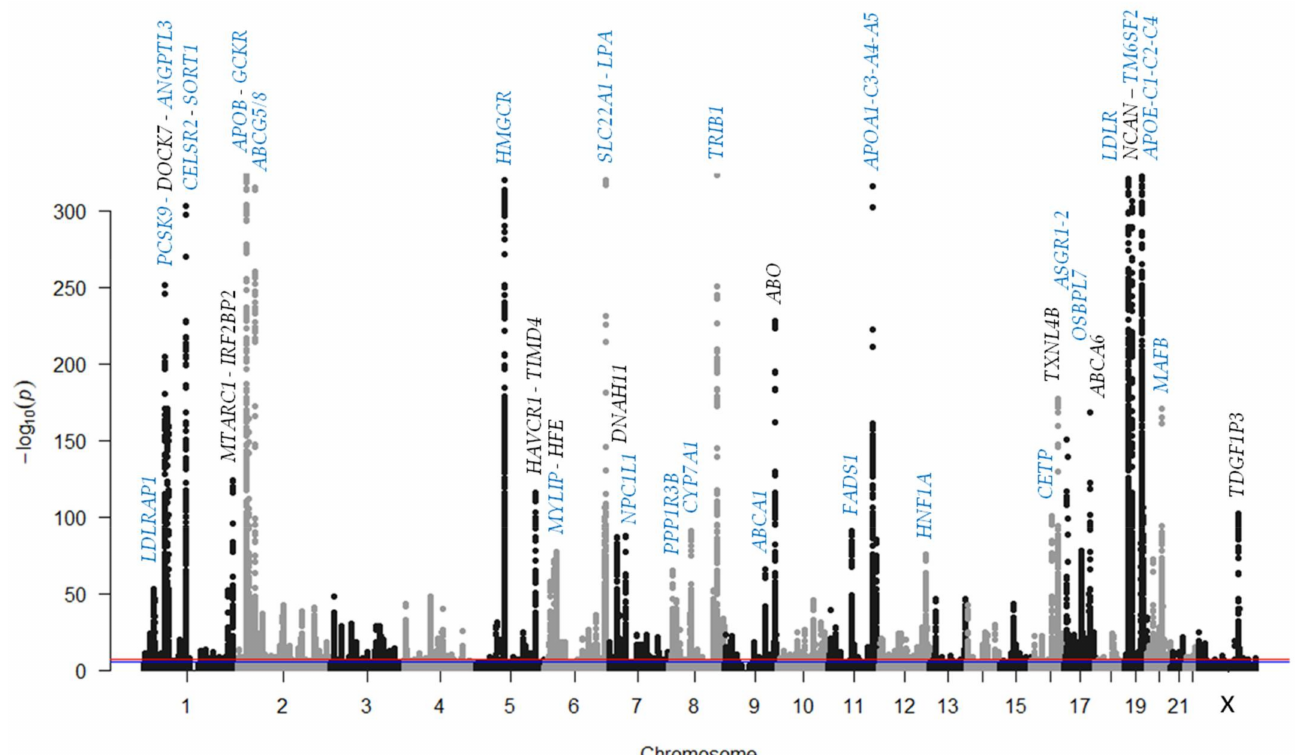
Figure 2. An example of a genome-wide association study (GWAS). A Manhattan plot was constructed from data taken from the summary statistics of Klimentidis et al. [95]—a GWAS performed on samples from the UK biobank. Only loci with p -values ≥ 1 × 10 − 50 are labeled. Genes related to lipid metabolism are labeled in blue. The red line marks the significant threshold ( p -value ≤ 5 × 10 − 8 ) and the blue line marks the highly suggestive threshold ( p -value ≤ 1 × 10 − 5